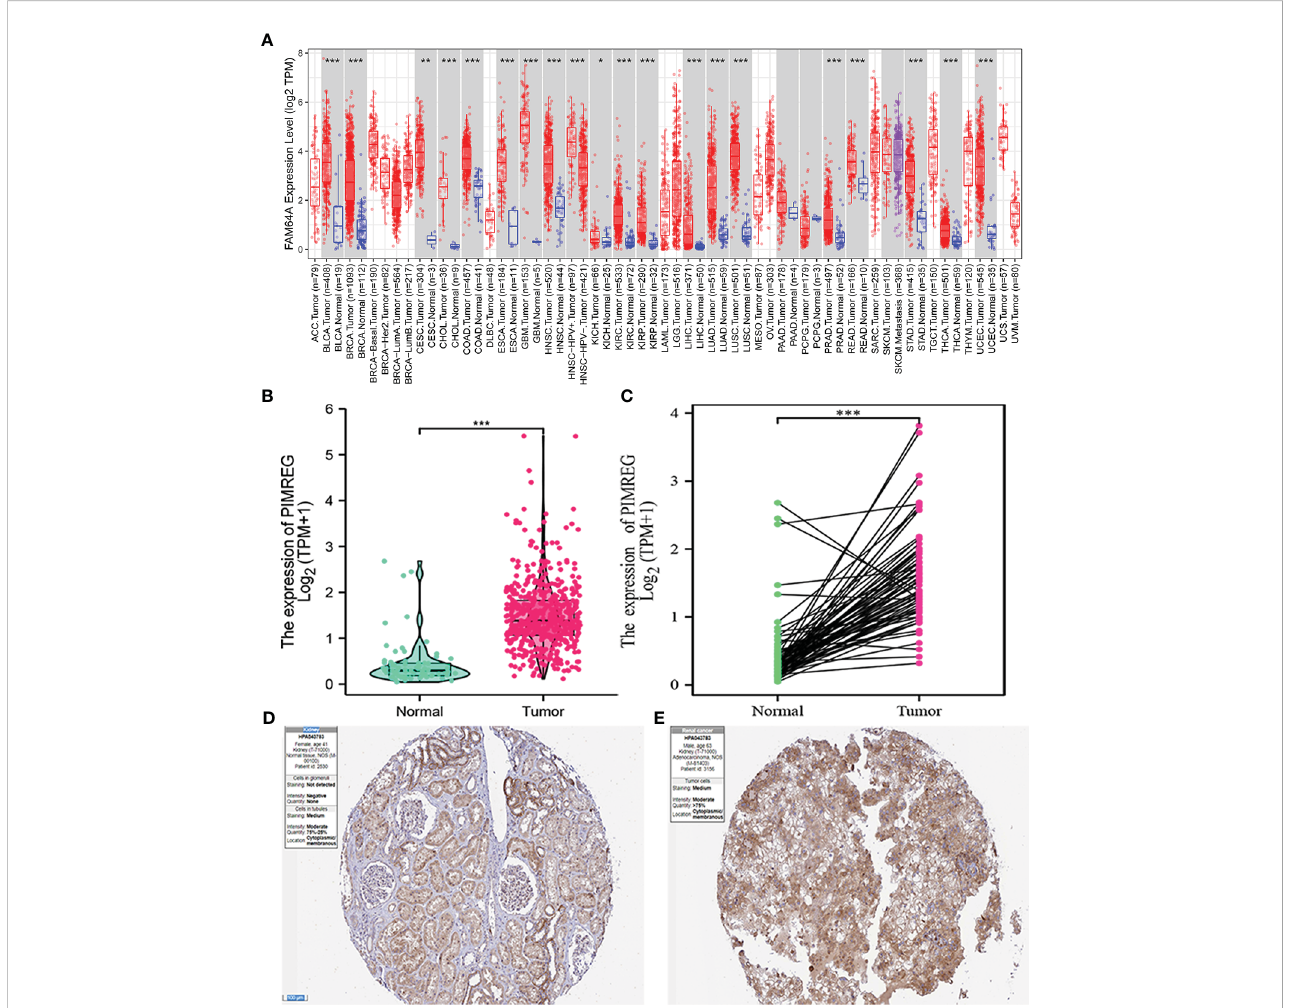
FIGURE 1 The mRNA and protein expression levels of PIMREG in ccRCC. (A) The mRNA expression levels of PIMREG in pan-cancer from TIMER2 database. (B) The mRNA expression levels of PIMREG in TCGA ccRCC database (T = 539, N = 72). (C) The PIMREG mRNA expression of pairwise ccRCC samples in TCGA dataset (T = 72, N = 72). (D) The protein expression levels of PIMREG in normal kidney tissues based on the Human Protein Atlas. (E) The protein expression levels of PIMREG in ccRCC tissues based on the Human Protein Atlas. *P < 0.05, **P < 0.01, ***P < 0.001; ccRCC: clear cell renal cell